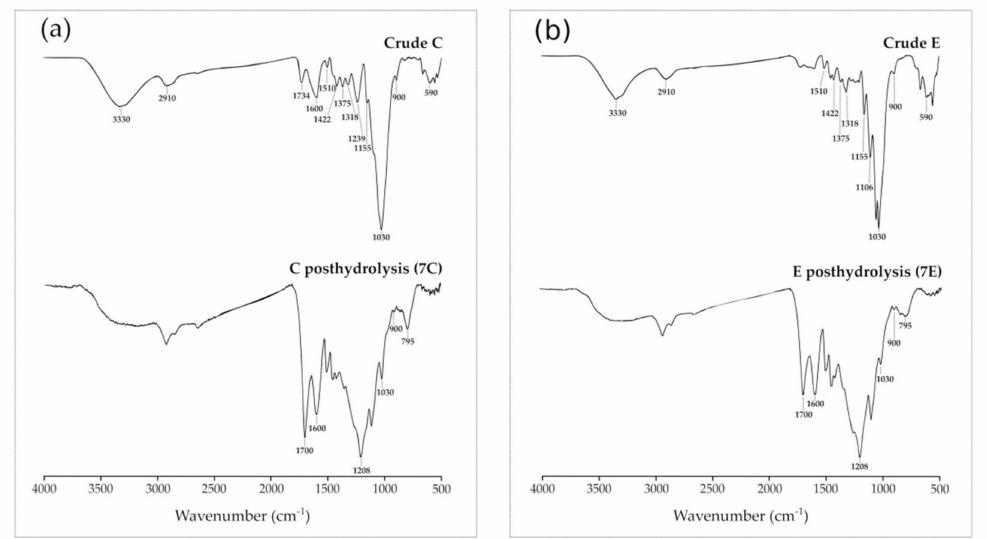
Figure 5. FT-IR spectra registered in ATR mode for the starting crude cardoon, both C and E samples, and for the solid residues recovered after hydrolysis reactions, runs E7 and